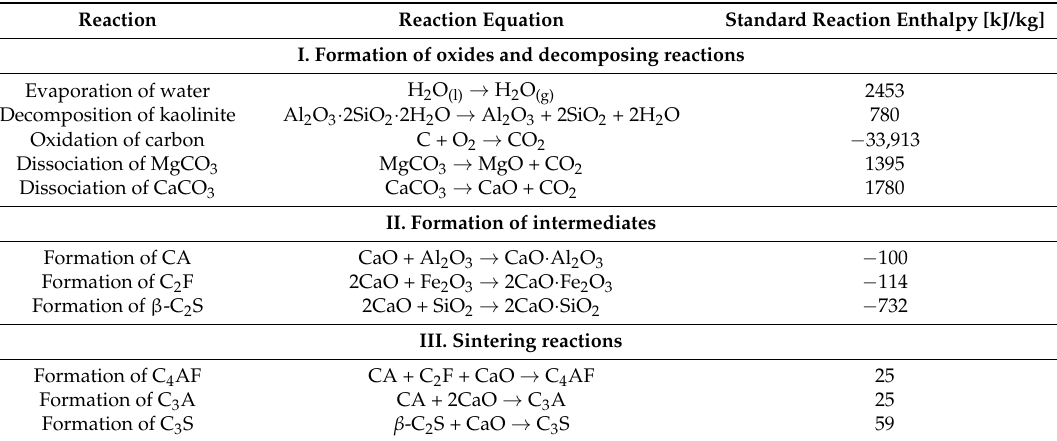
Table 1. Reactions and reaction enthalpies [32].